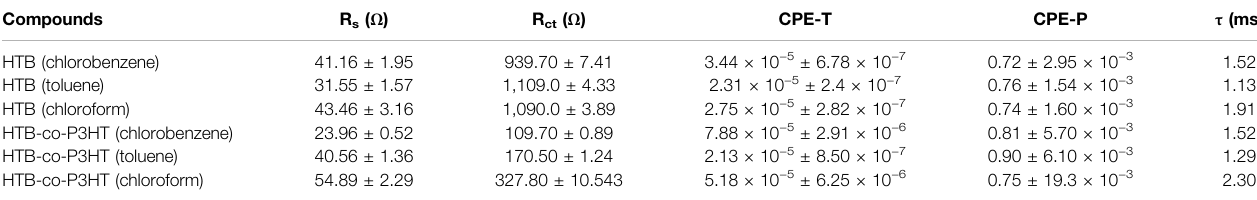
TABLE 3 | EIS results for HTB and HTB-co-P3HT prepared in various solvents. Compounds